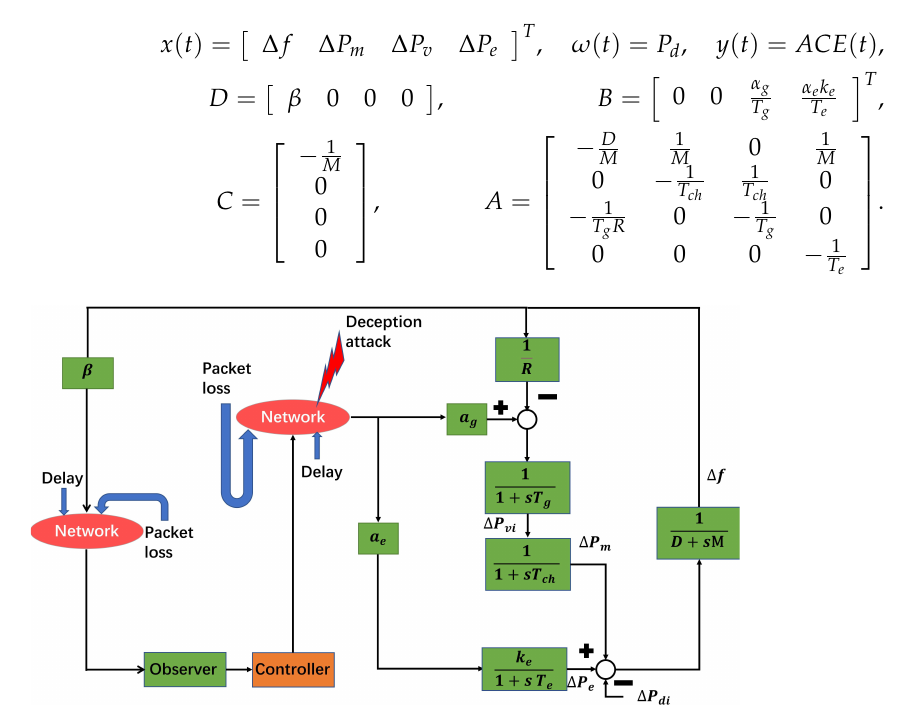
Figure 1. System LFC model including electric vehicles.